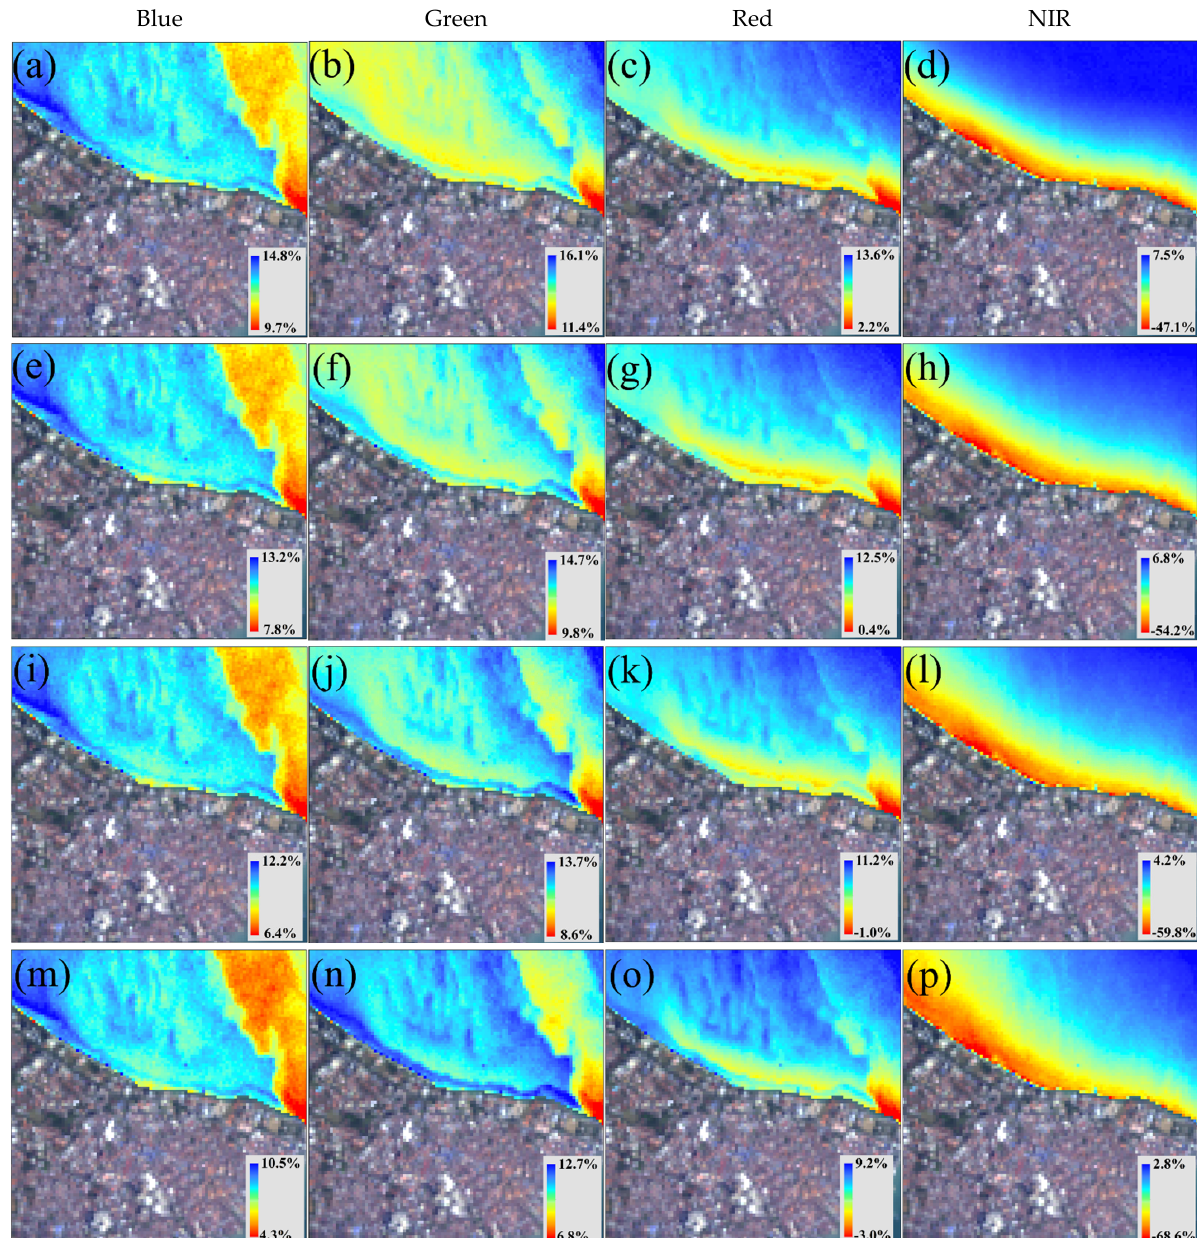
Figure 5. Distribution of R rc by the band for Mixed Zone in Penang. ( a – d ) are R ns = 1 km, ( e – h ) are R ns = 1.5 km, ( i – l ) are R ns = 2 km, and ( m – p ) are R ns = 3 km. The differences between the two models in the blue, green, red, and NIR bands are shown.